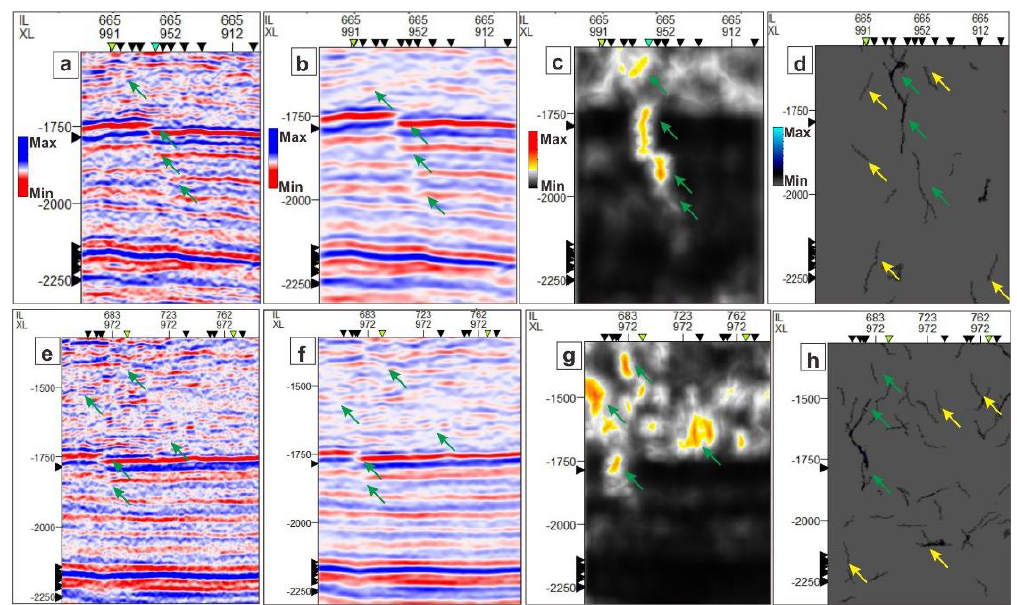
Figure 15. ( a , e ) Original seismic at inline 665 and crossline 972, respectively; ( b , f ) structural smoothing applied on the original seismic; ( c , g ) variance attribute; and ( d , h ) ant-tracking attribute. The green arrows highlight the faults, and yellow arrows show fractures.